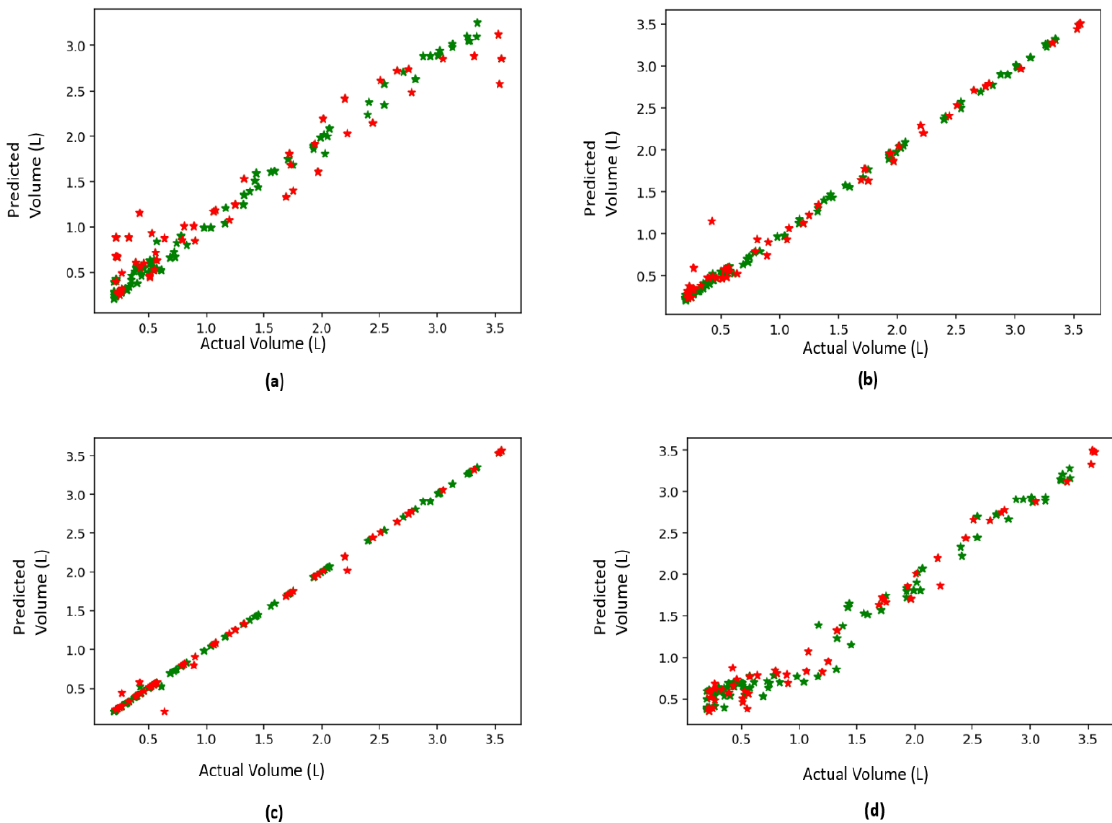
Figure 10. Results of the 10-fold cross-validation testing procedure: ( a ) random forests regressor, ( b ) gradient boost regressor, ( c ) decision trees regressor, and ( d ) adaptive boosting regressor.